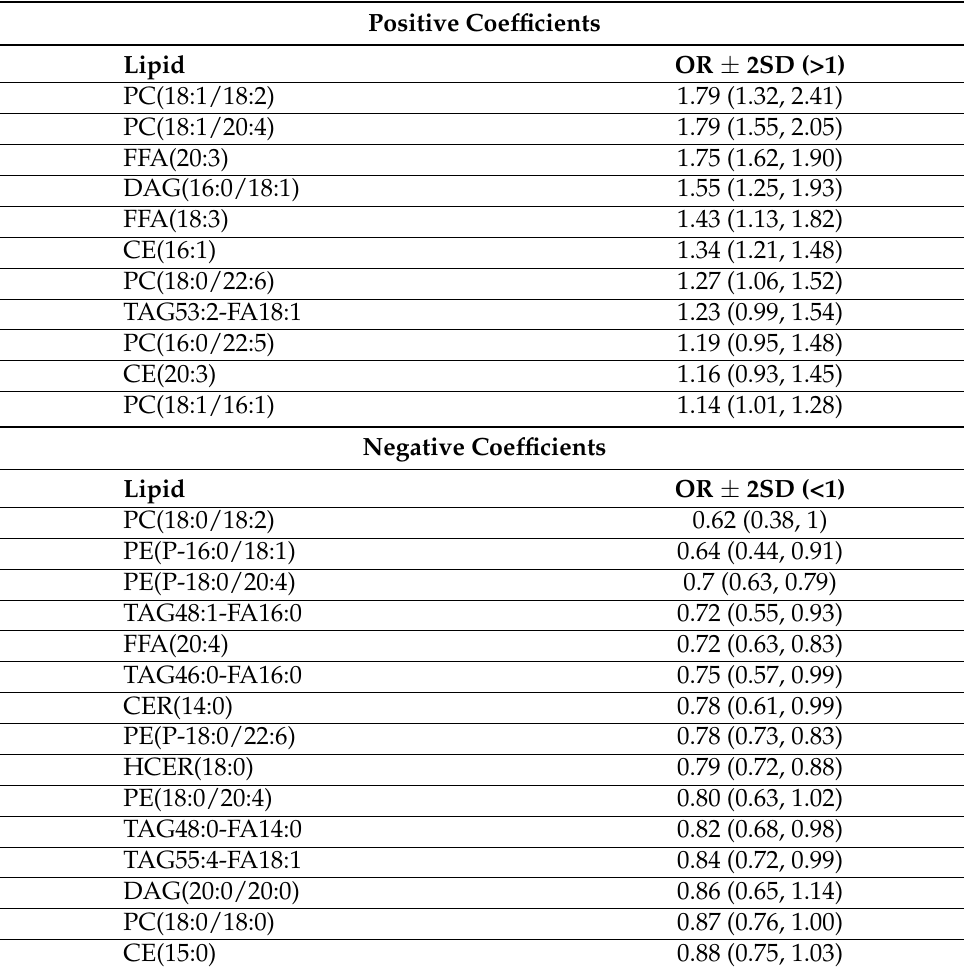
Table A3. Names and OR (associated with a standard deviation increase in concentration) for lipids retained in all five elastic net models fit on the full data to classify PD patients against AD patients. A metabolite with OR > 1 indicates that a higher concentration is associated with AD in our models. Only ORs with magnitude greater than 1.1 or less than 0.9 are shown